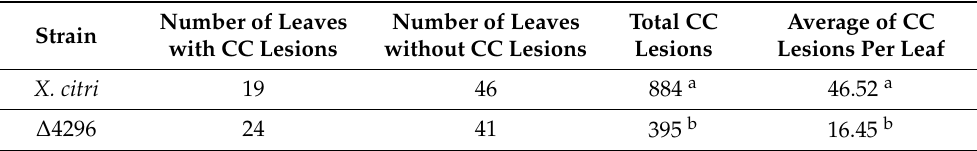
Table 1. Citrus canker quantification of “Pera Rio” orange leaves ( Citrus sinensis L. Osbeck) by spray method. Strains were inoculated in a total of 65 leaves. The number of lesions was quantified on the abaxial surface of the leaves. Number of Leaves Number of Leaves Total CC Average of CC Strain with CC Lesions without CC Lesions Lesions Lesions Per Leaf X. citri